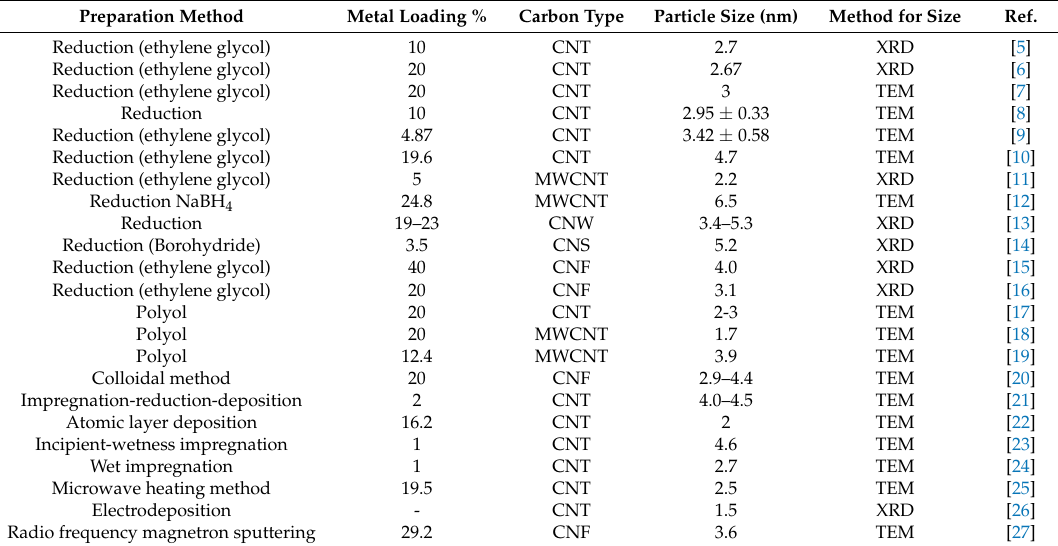
Table 1. Summary of supports, precursors, synthesis pH, and particle